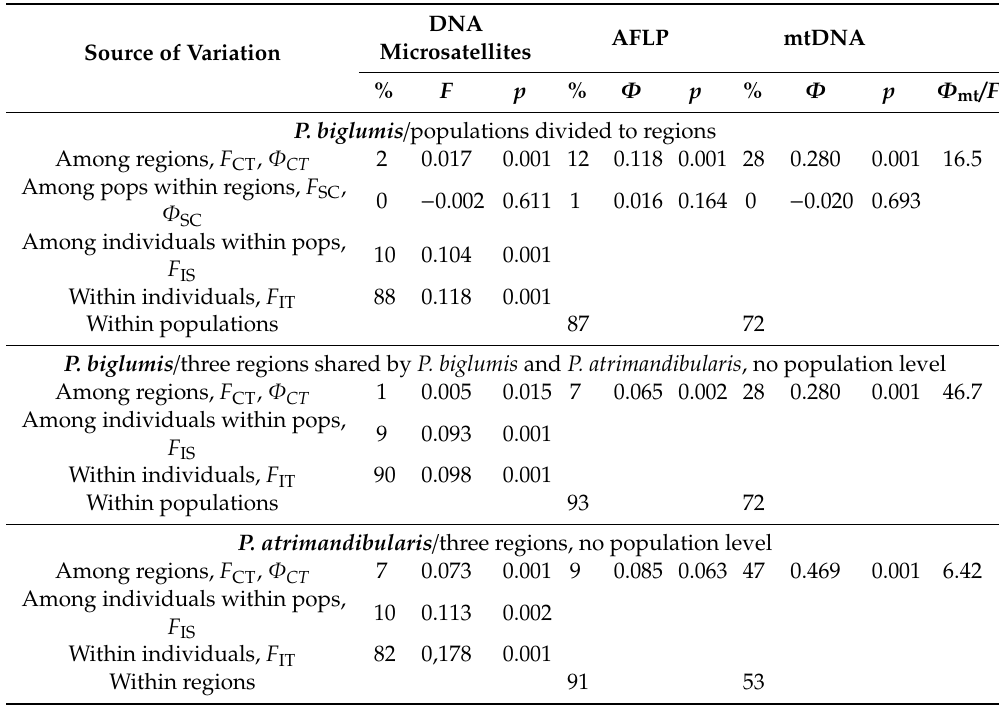
Table 2. AMOVA results, with the proportion of genetic variation at di ff erent hierarchical levels (%) and the associated fixation indices for DNA microsatellites ( F ), AFLP, and mitochondrial markers ( Φ ). The ratio of mitochondrial to DNA microsatellite di ff erentiation ( Φ / F ) is given when both values are positive. Note that AFLP markers and mitochondrial sequences are haploid and the within individual level is therefore substituted by the within-population / regions level. DNA microsatellite and AFLP analysis is based on 14 populations with n > 2, and mitochondrial analysis on 18 populations with n ≥